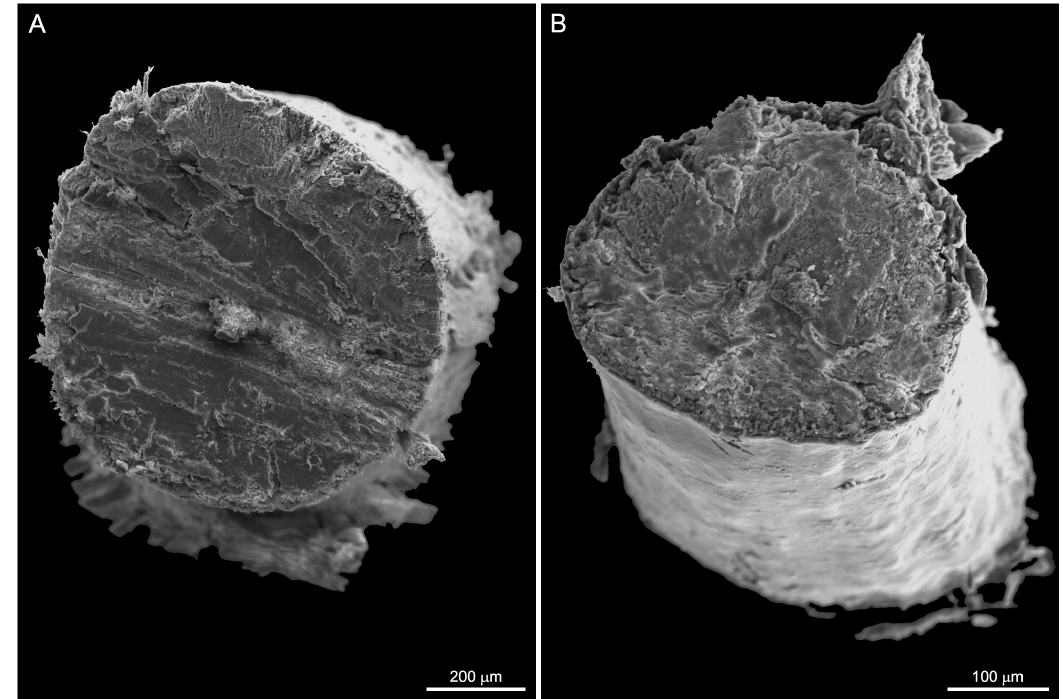
Fig. 3. Transversal section of the central axis of paratype B of Umbellula pomona Risaro, Williams & Lauretta sp. nov. (MACN-IN 42609). A . Transversal section of the central axis between the peduncle and the rachis. B . Transversal section of the central axis near the terminal